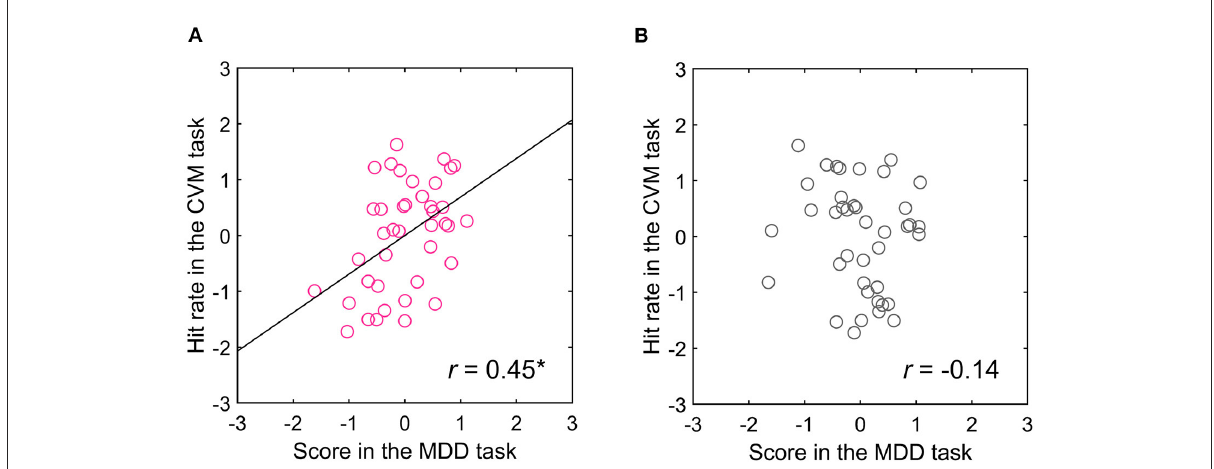
FIGURE10 Relationship between the scores in the MDD task at C70 for the TAV hemifield and the CVM task at 5000 pixels/s by participants with (A) more than 8 years of competitive experience and (B) < 8 years. ** p < 0.001.